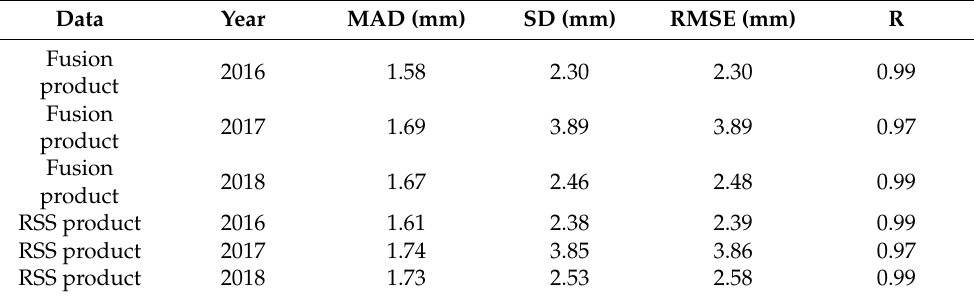
Table 4. Accuracy comparison between the fusion product and RSS product from 2016 to 2018. The monthly water vapor of each month from 2016 to 2018 was obtained using the fusion water vapor data.